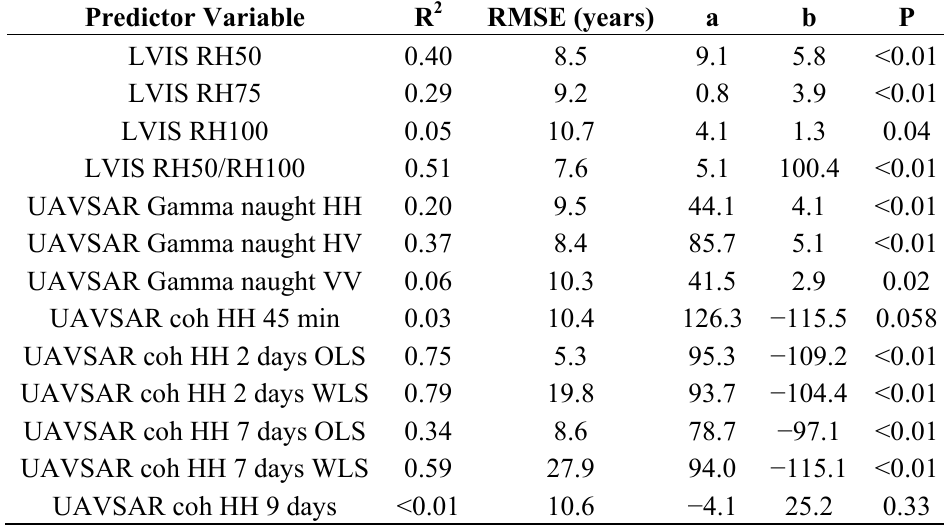
Table 2. Modeling forest patch age from active remote sensing data. Regression equations are of the form Age (years) = a + b × X where X is the predictor variable. Statistically significant models are shown in bold. OLS = ordinary least squares; WLS = weighed least squares. Minimum overlap with UAVSAR/LVIS swath is 5